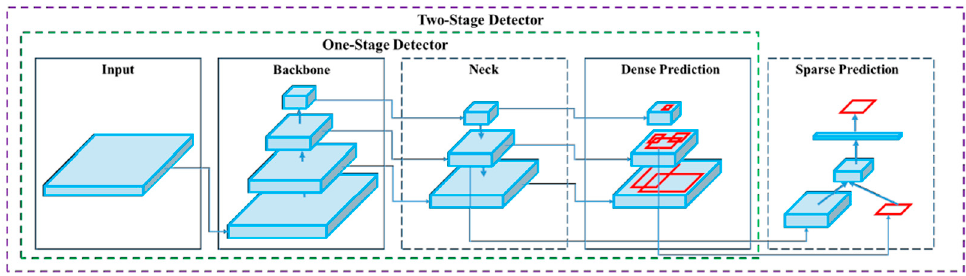
Figure 6. Architecture of the one-stage and two-stage object detectors [32].